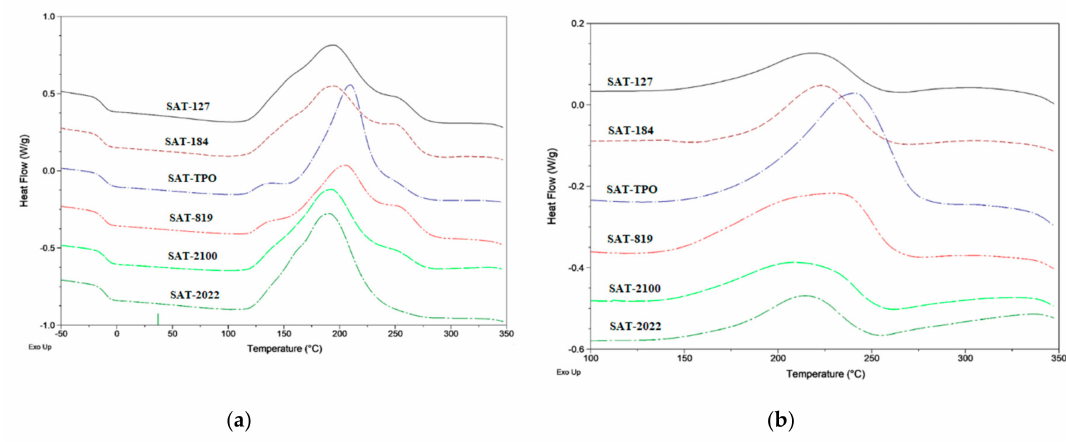
Figure 4. Di ff erential scanning calorimetry (DSC) thermographs for the uncured SATs ( a ) and cured SATs ( b ) based on